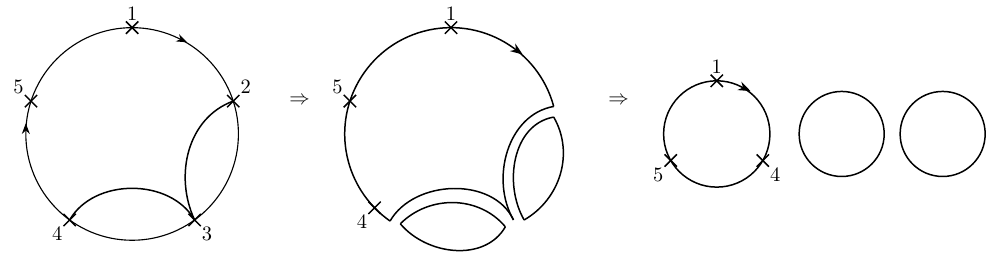
Figure 3 . Computing the contribution of r 1 6 = r 2 = r 3 = r 4 6 = r 5 to C 5 . Crosses 2,3 and 4 are joined as shown on the left. After thickening the chord joining these crosses, erasing the smaller labels 2 and 3 and sliding 4 along toward 5, this diagram splits into three disconnected